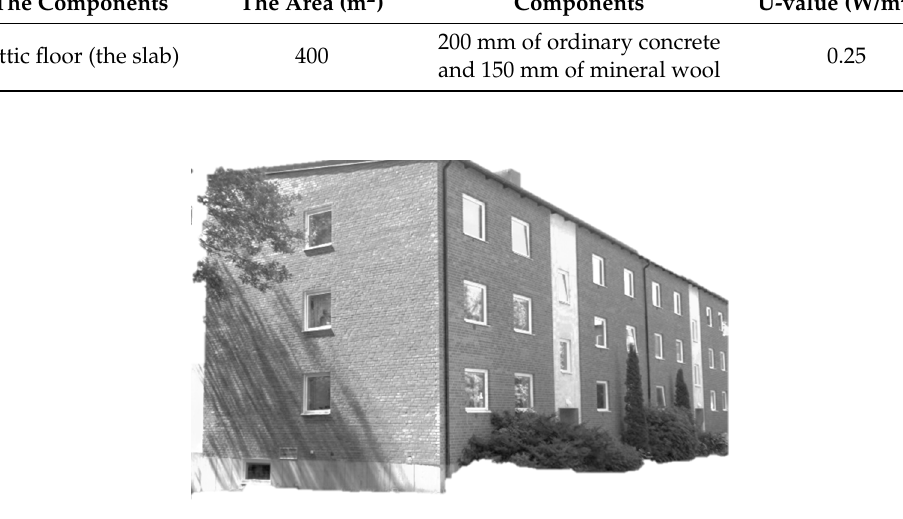
Figure 3. North-east view of the case-study building. Figure 3. North ‐ east view of the case ‐ study building. Figure 3. North ‐ east view of the case ‐ study building.